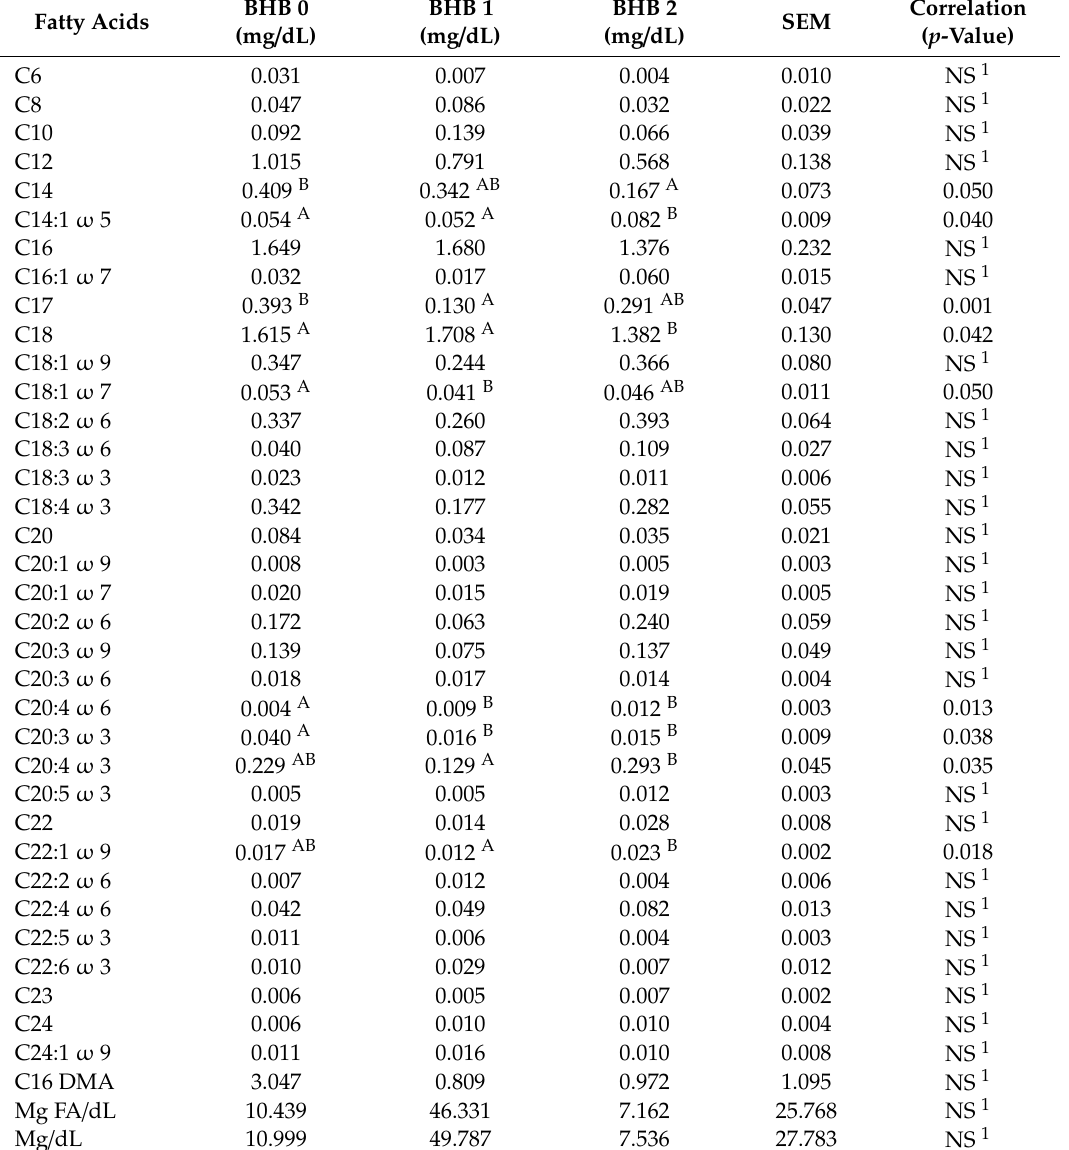
Table 5. Plasma fatty acid mean ( ± SEM) related to the lipid class of Triglycerides (TLC-GC). Fatty